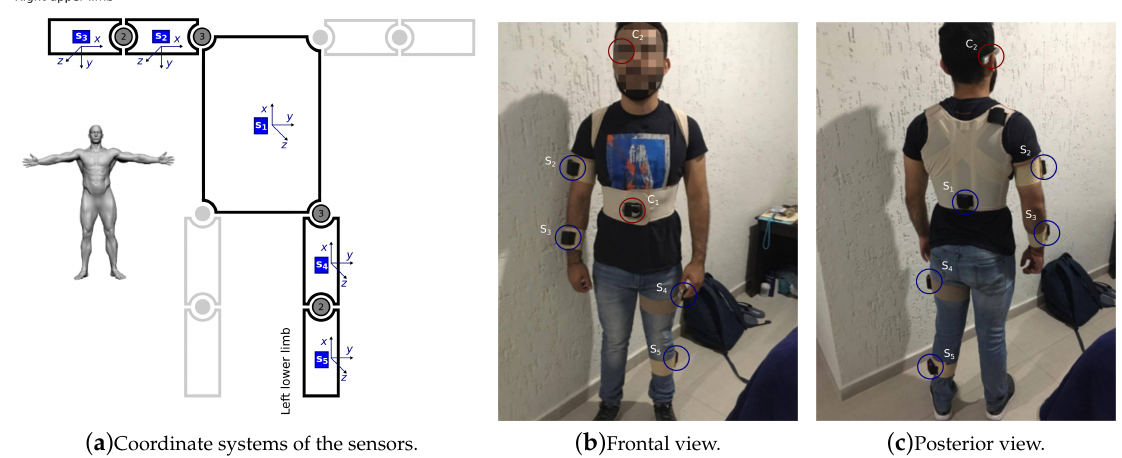
Figure 1. Configuration of the wearable sensors placed on the right upper limb ( S 2 and S 3 ), the left lower limb ( S 4 and S 5 ) and the lower back ( S 1 ) of a test subject. Two cameras were carried, one in the front side of the vest, C 1 , and one in the lenses, C 2 , for labeling